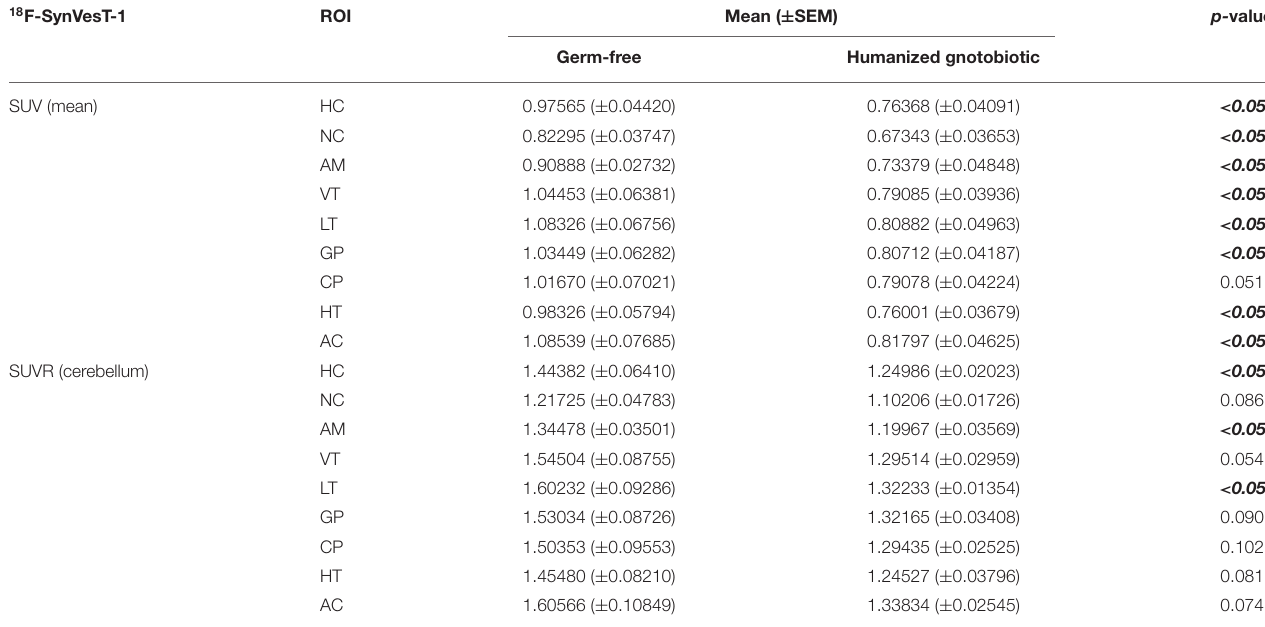
TABLE 2 | Gut microbiota are associated with significant alterations in synaptic